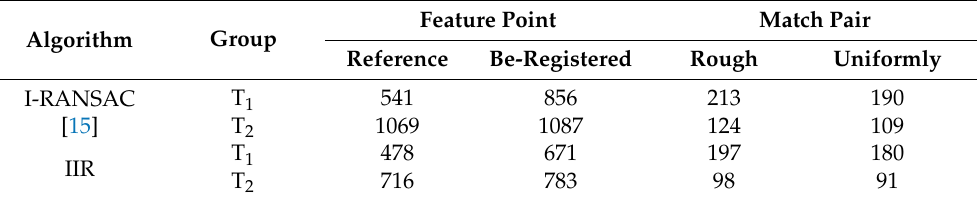
Table 2. A comparison of feature point information between two algorithms.